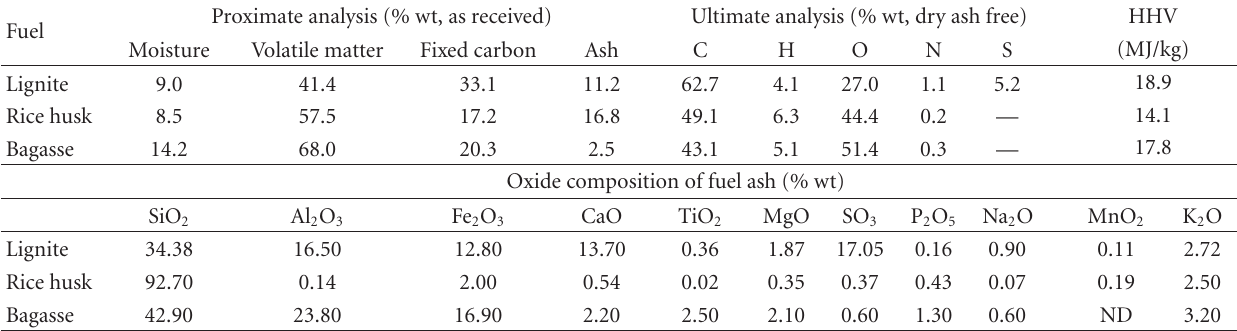
Table 1: Fuel properties.